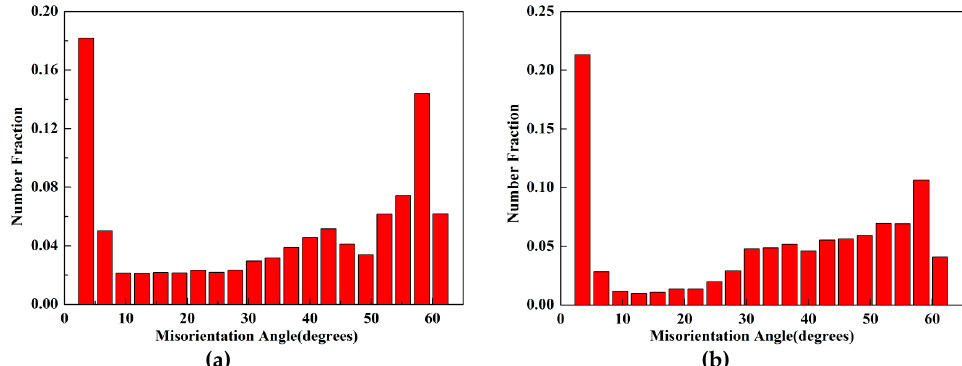
Figure 14. Misorientation distribution of grain boundaries in the initial phase zone with different deformation ratios; ( a ) ε = 0; ( b ) ε = 0.04; ( c ) ε = 0.607.